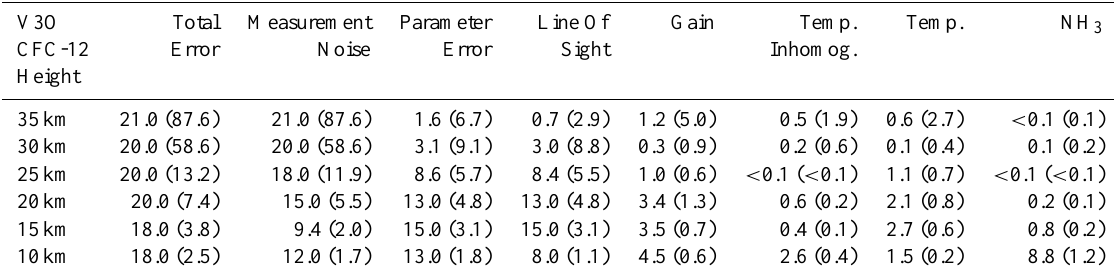
Table 6. Error budget of a V3O CFC12 10 (FR nominal mode) retrieval from spectra recorded at 63 ◦ S, 164 ◦ E on 21 May 2003 at 22:51 UTC for selected altitudes. The errors are given in units of pptv(%). Details as for Table 2.